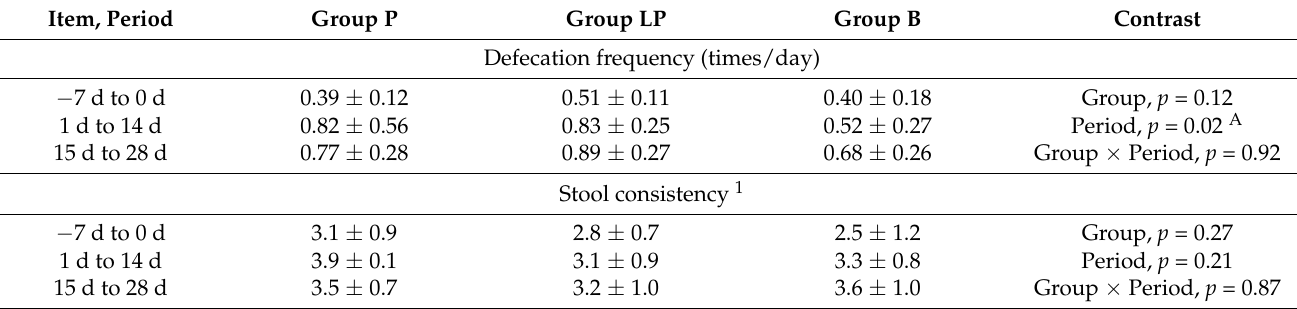
Table 5. Changes in defecation frequency and stool scaling in response to ingestion of fermented B. rapa L., divided by the grouping based on stool bacteria profile.